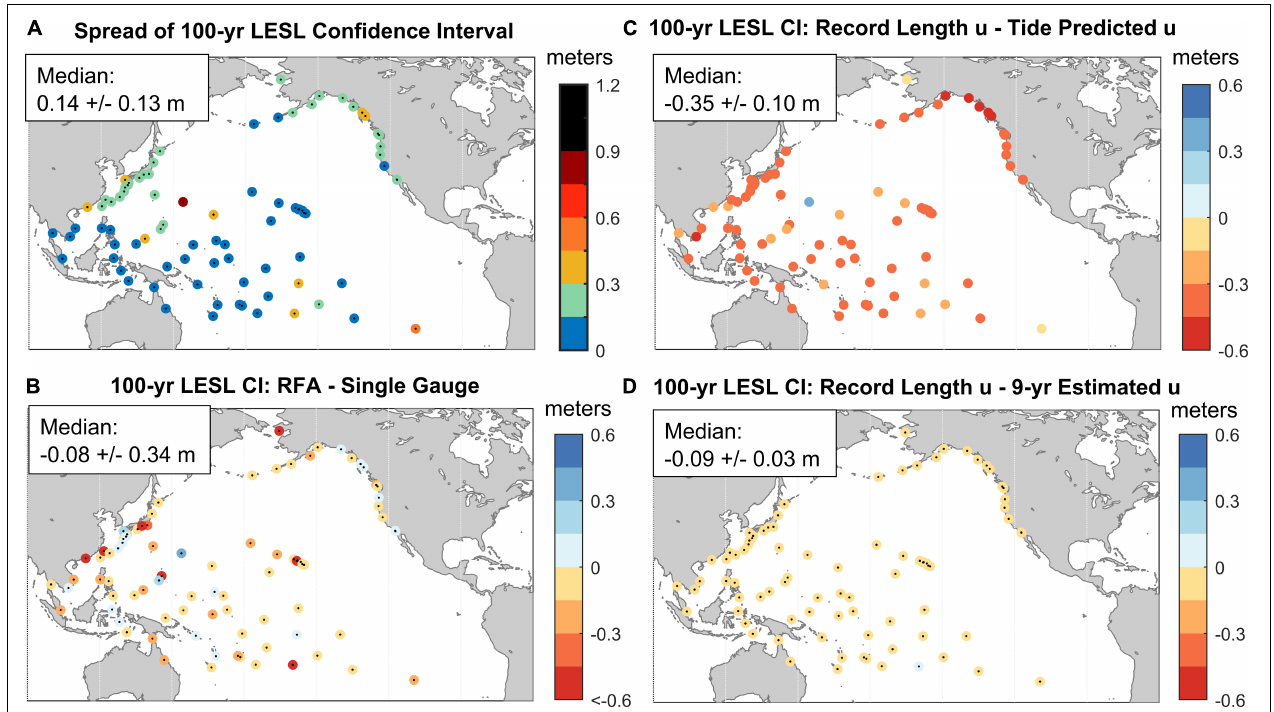
FIGURE 7 | The spread of the 100-year LESL 90% confidence interval using (A) the RFA values and the differences with those computed using (B) a single TG GPD analysis, (C) RFA estimates predicted from tide range ( Figure 4A ) and (D) 9-year estimates of u ( Figure 4B ).